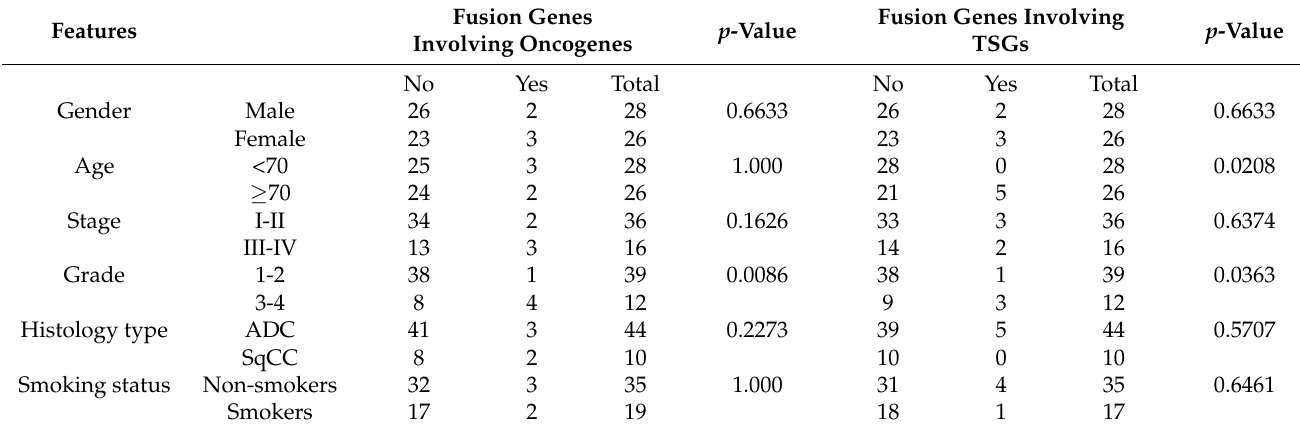
p -value by Fisher’s exact test. All subjects underwent surgical resection. Patients were diagnosed according to the 2015 World Health Organization and International Association for the Study of Lung Cancer guidelines. Staging was based on the guidelines of the eighth edition of the TNM classification for